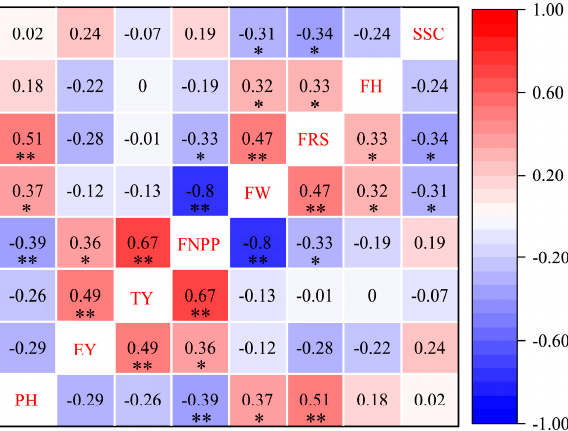
Lowercase letters and uppercase letters indicate significance at 0.05 and 0.01 probabilities, respectively.